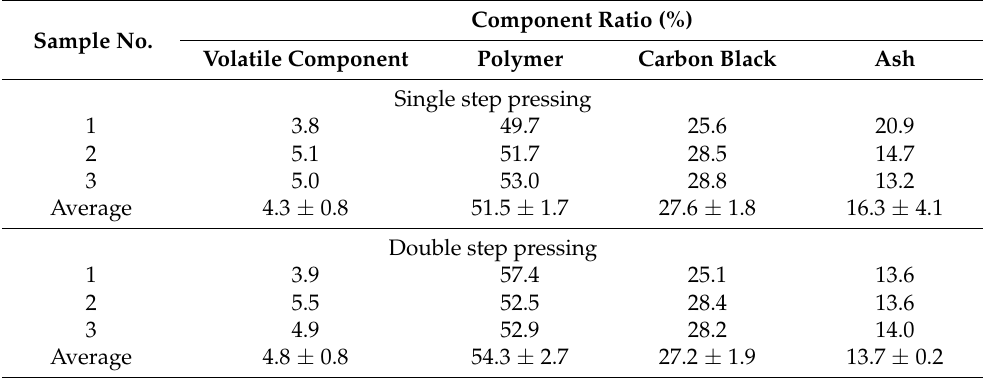
Table 3. TGA results of the model TRWPs made of the chloroform-treated TWPs. Sample